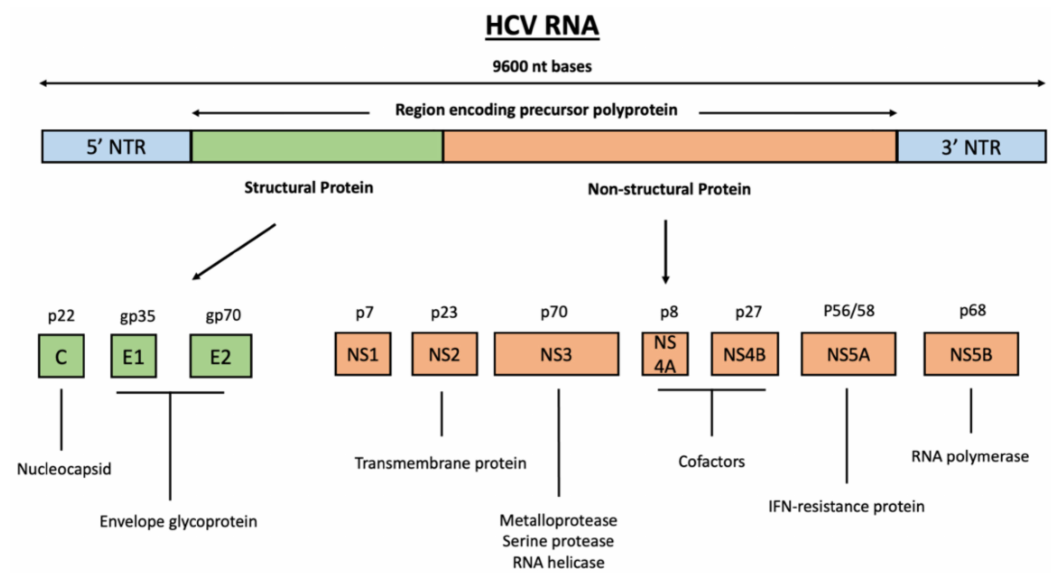
Figure 1. Proteins encoded by the HCV genome. HCV viral genome encodes one long polyprotein that is co- and post- translationally processed into mature structural and non-structural proteins. The viral structural proteins (green) include the core protein and envelope glycoproteins E1 and E2; the viral non-structural proteins (orange) consist of NS1, NS2, NS3, NS4A, NS4B, NS5A, and NS5B